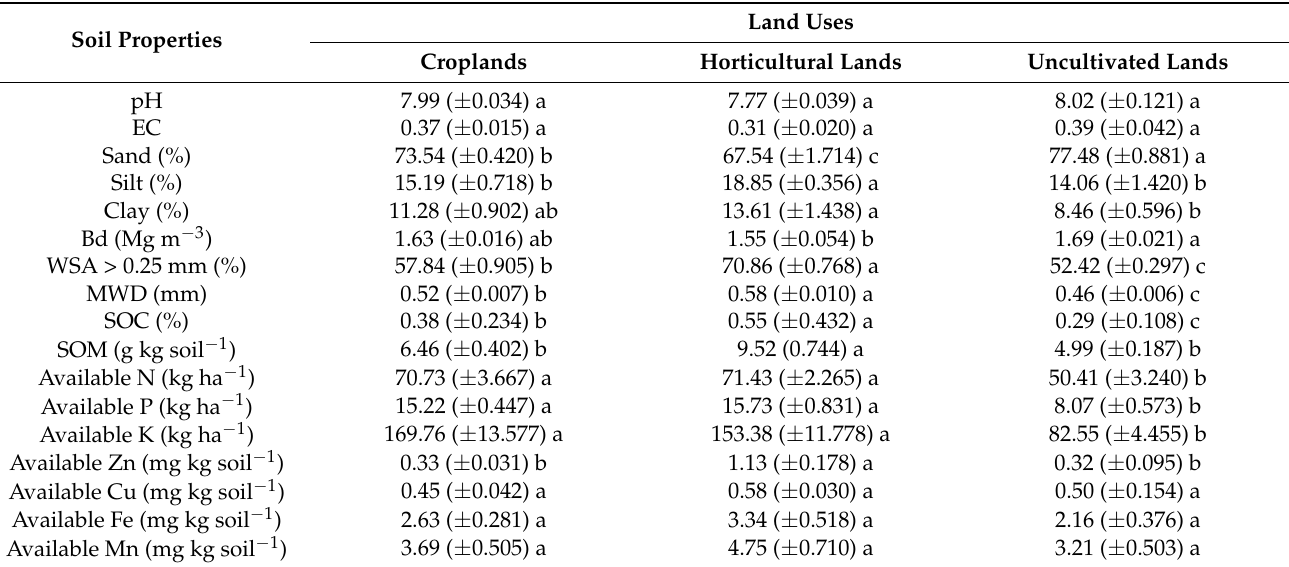
Table 5. Weighted means of soil physicochemical properties and nutrient status under different land uses (data pooled for soil depths) in south-western Punjab,